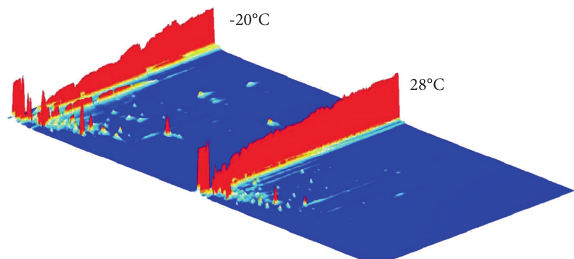
Figure 1: Three-dimensional topographic of the volatile compo- nents of RJ stored at − 20 ° C and 28 ° C,